Question: What kind of plot is shown here?
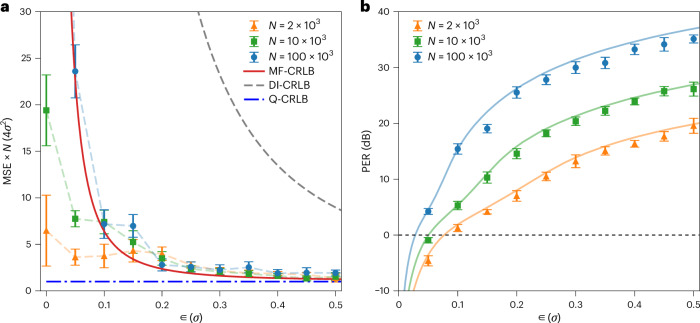
Answer: bar